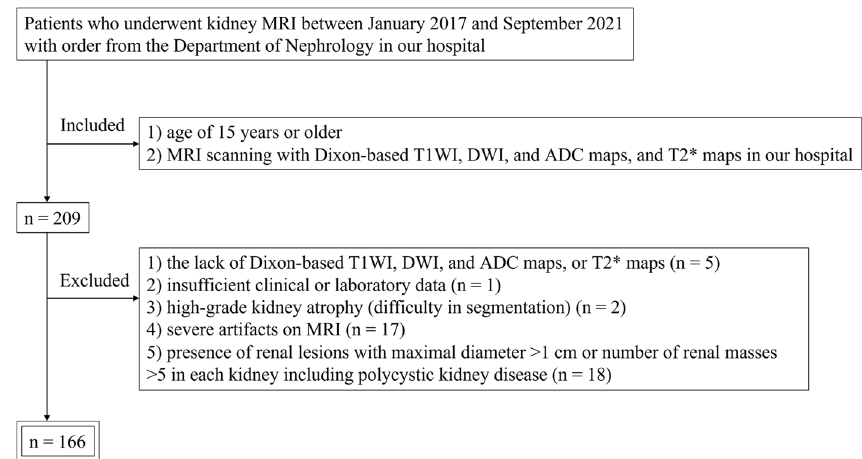
Figure 3. Flow chart of the inclusion and exclusion criteria for the study. ADC apparent diffusion coefficient, DWI diffusion-weighted imaging, MRI magnetic resonance imaging, T1WI T1-weighted imaging.